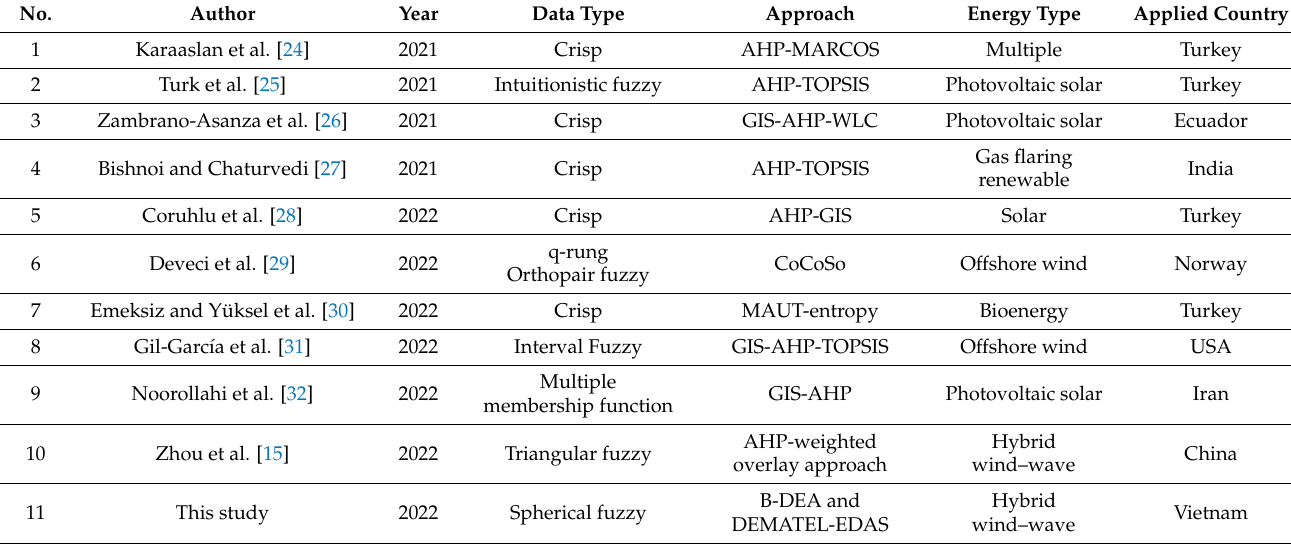
Table 1. MCDM application for renewable energy site selection